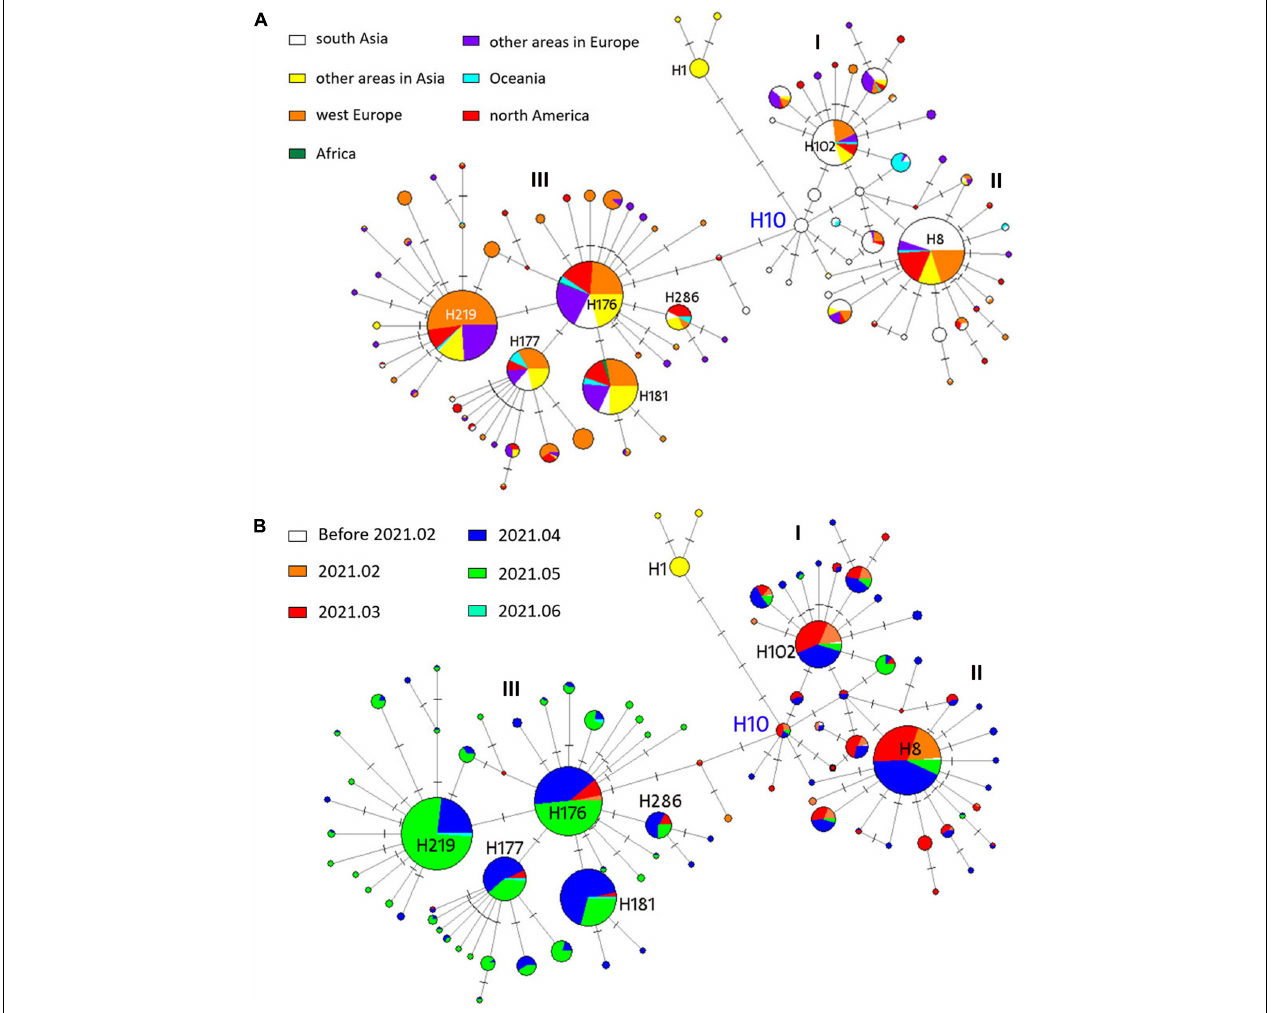
FIGURE 4 | Phylogenetic network analysis of 1159 B.1.617 S genes. Circle areas in panel (A) are proportional to the number of geographical sites and in panel (B) are proportional to the time period. Each notch on the link represents a mutated nucleotide position. H10 was the root cluster of B.1.617 obtained with the early isolates in 2020.